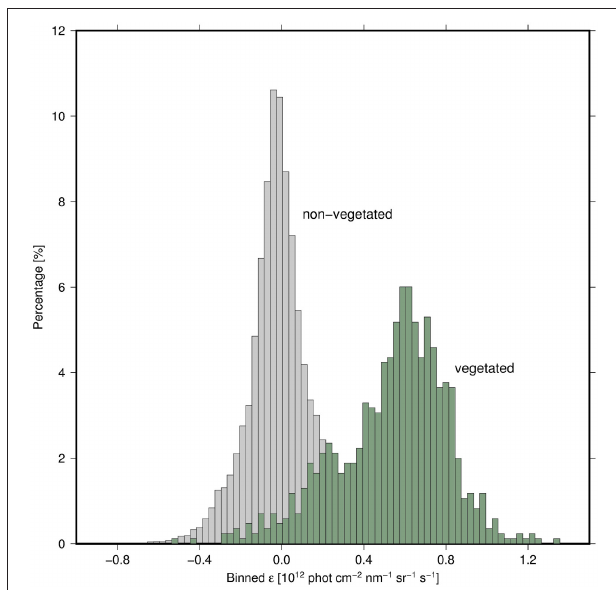
FIGURE 5 | Distributions of ε f = ε − ε a ( ¯ I m ) values for vegetated and non-vegetated regions shown by green and gray colors, respectively.